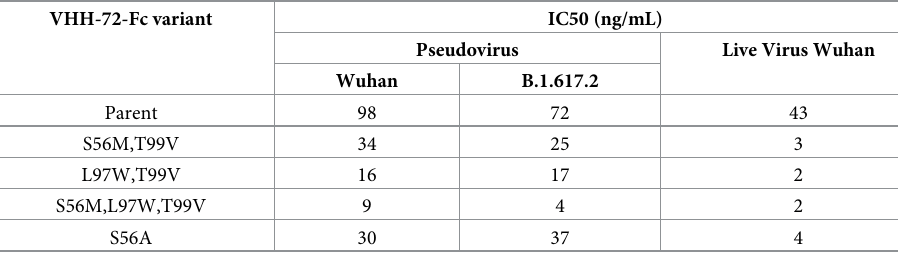
Table 3. In vitro SARS-CoV-2 neutralization efficacy of VHH-72-Fc mutant